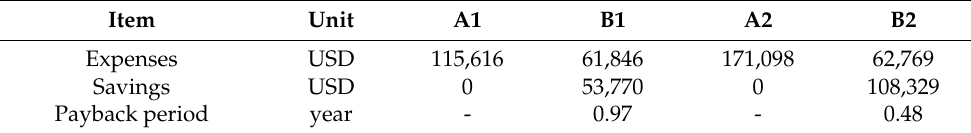
Figure 6. Percentage distribution of operating expenses: ( A1 ) processing 5% H 2 SO 4 wastewater without DD; ( B1 ) processing 5% H 2 SO 4 wastewater with DD; ( A2 ) processing 10% H 2 SO 4 wastewater without DD; ( B2 ) processing 10% H 2 SO 4 wastewater with DD. Table 10. Annual cash flow for each case and expected payback period for DD investment.